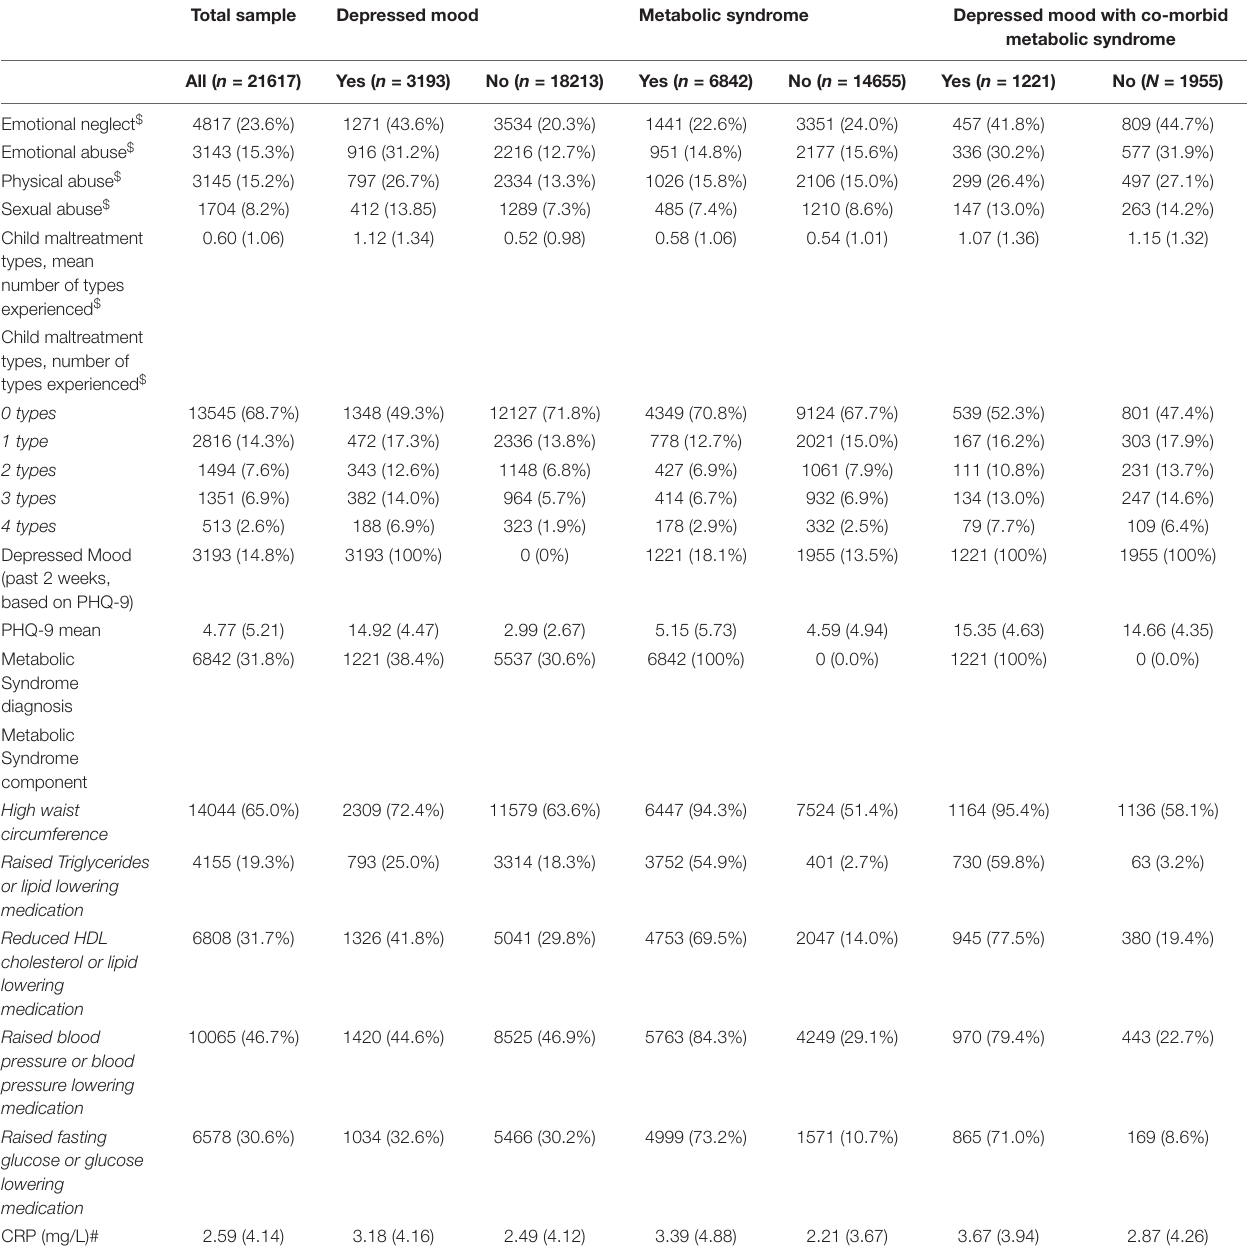
TABLE 2 | Descriptive information regarding child maltreatment, depressed mood, metabolic syndrome, and C-reactive protein